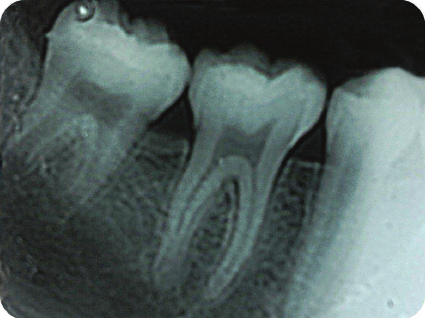
Figure 7: Posttreatment intraoral periapical radiograph showing erupted permanent mandibular second molar